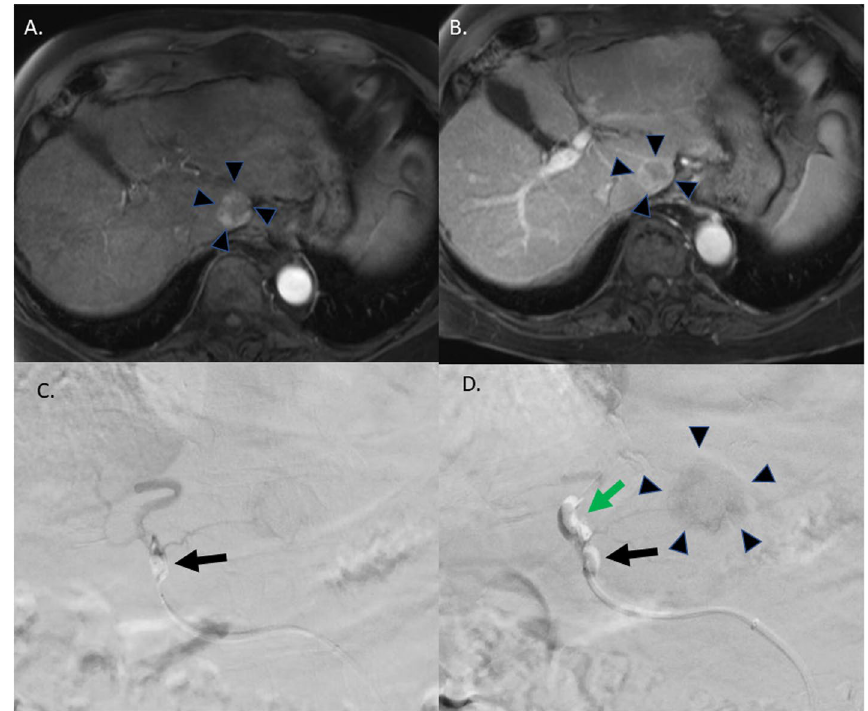
Fig. 1 a-d Treatment of a OPTN5B caudate lesion. a Surveillance MRI in this patient with cirrhosis demonstrated an arterially enhancing lesion measuring 2.3 cm centered in segment 1(black arrow heads) with b early washout and pseudocapsule formation deeming it OPTN5b and was referred for Y‑90 radioembolization. His Pre‑SIRT and SIRT studies demonstrated the caudate lobe artery arising from the proximal left hepatic artery with single tumor blush but with substantial adjacent supply to segments II/III and IV. Given desire to reduce risk of hepatic parenchymal embolization due to comorbidities of cirrhosis and portal hypertension, the double balloon technique was used. A 2.1 French Sniper catheter was positioned beyond the caudate artery. c A second 2.1 French angled Sniper catheter was placed and positioned at the proximal left hepatic artery proximal to the caudate artery (black arrow). d Both balloons were inflated with dilute contrast per manufacturer protocol (green and black arrows). Digital subtraction angiography from the proximal catheter demonstrated selective flow of contrast into caudate artery with avid enhancement of target lesion (black arrow heads), and minimal, sluggish flow beyond the second/distal Sniper balloon, so Y‑90 Theraspheres were